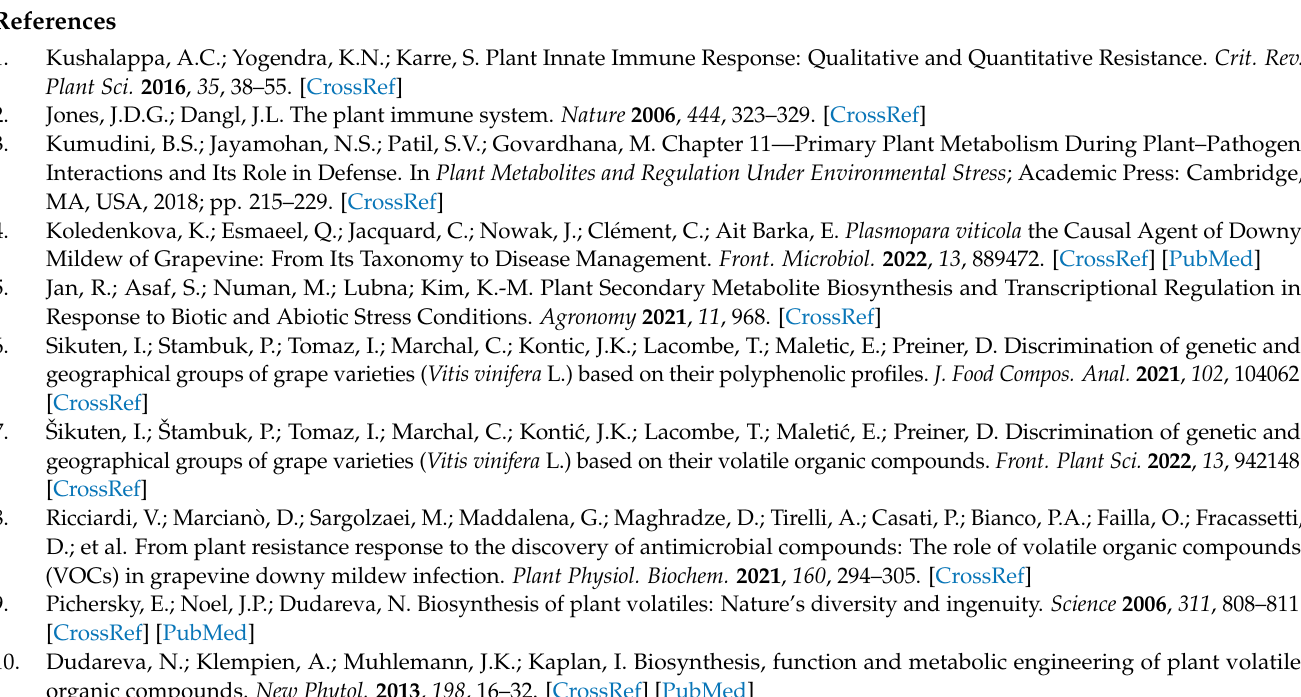
Interactions, Table S3: ANOVA_Term_Treatment_OIV class, Table S4: